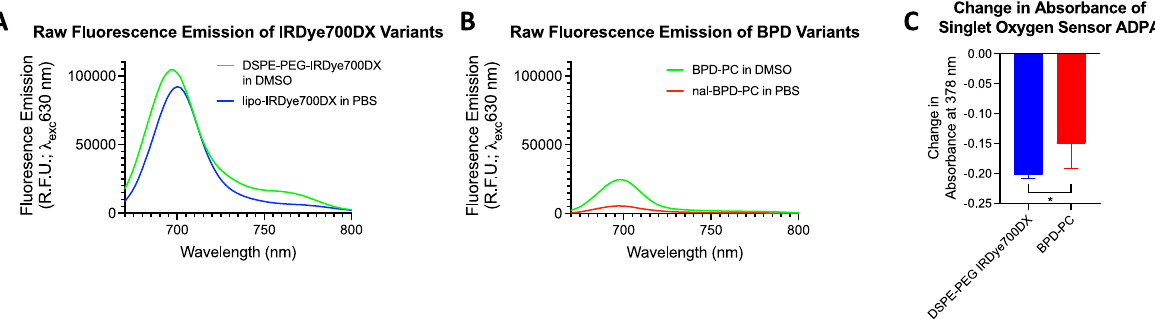
Figure 3: Raw fluorescence emission spectra of DSPE-PEG IRDye700DX and lipo-IRDye700DX (A) and of BPD-PC and lipo-BPD-PC (B) using Exc 630nm torevealthefullemissionbandpro fi lesandtosimulatetheexcitationofthe invivo fl uorescenceimagingsystem.(C)Singletoxygen production by the unformulated lipid conjugates of IRDye700DX and BPD in DMSO detected by a decrease in absorbance of the colorimetric singletoxygenprobe,anthracenedipropionicacid(ADPA;maximumpeakcenteredat378nm).BPD-PCproduces25%lesssingletoxygenthan DSPE-PEG IRDye700DX.